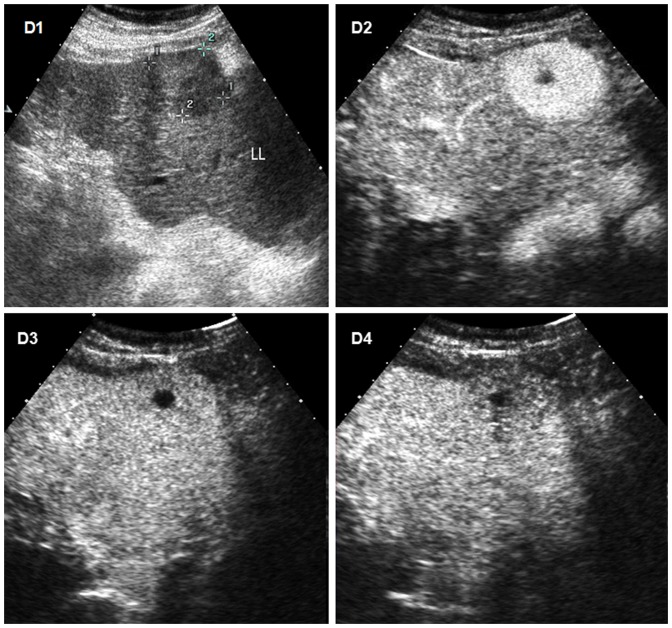
Hepatocellular carcinoma (HCC) with moderate differentiation in a 72-year old man with cirrhosis.D1 Conventional ultrasound shows a hypoechoic nodule of 41(L L) of liver. D2 The lesion shows heterogeneous hyperenhancement 25 seconds after the administration of contrast agent at CEUS, the non-hyperenhancement area at the central part of the lesion indicating necrosis. D3 The lesion shows no wash-out appearance 60 second after injection of contrast agent. D4 The lesion displays mild wash-out 185 seconds after the administration of contrast agent.